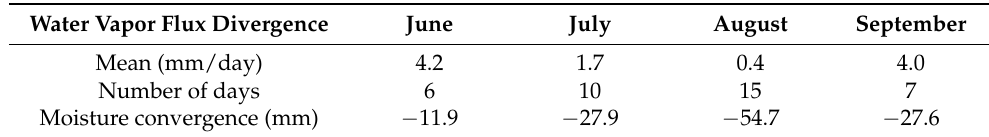
Figure 8. Pattern of vertical velocity (coloring), relative humidity (green line) and wind vector varying with pressure during monsoon period (June–September) along 28 ◦ N and 80–90 ◦ E. The filled gray region represents the mountain topography. Table 4. The average value of water vapor flux divergence, the number of days with negative water vapor flux and sum of moisture